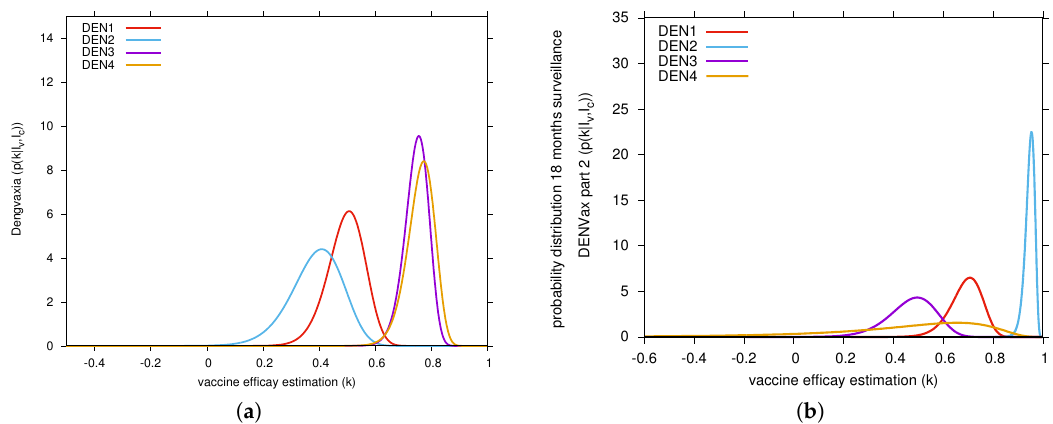
Figure 3. Bayesian estimate of vaccine efficacies (VE) against virologically confirmed dengue. In ( a ) serotype-specific VE for Dengvaxia, Sanofi Pasteur. The raw data used for VE estimation by dengue serotype for individuals aged 9 years and older was obtained in [8]. In ( b ) serotype-specific VE for DENVax, Takeda. The raw data used to estimate the VE by dengue serotype for individuals aged 4–16 years old was obtained in [10] and are shown in Table